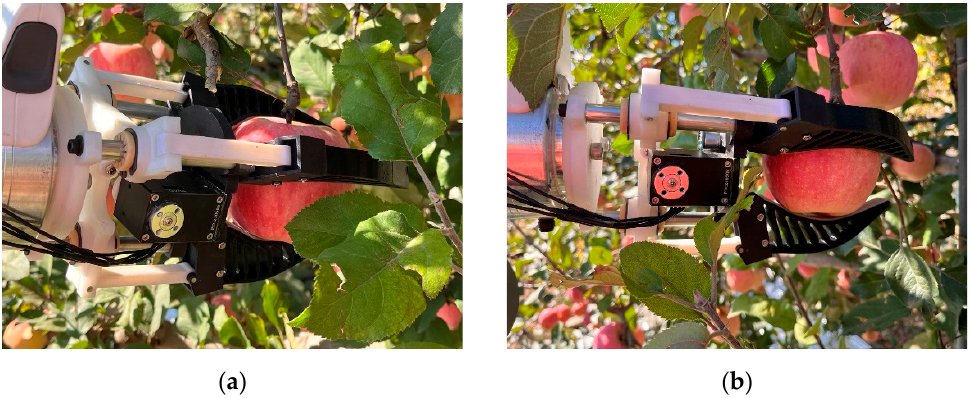
Figure 24. Gripper attitude with force feedback on and off: ( a ) force feedback on; ( b ) force feed- back off.